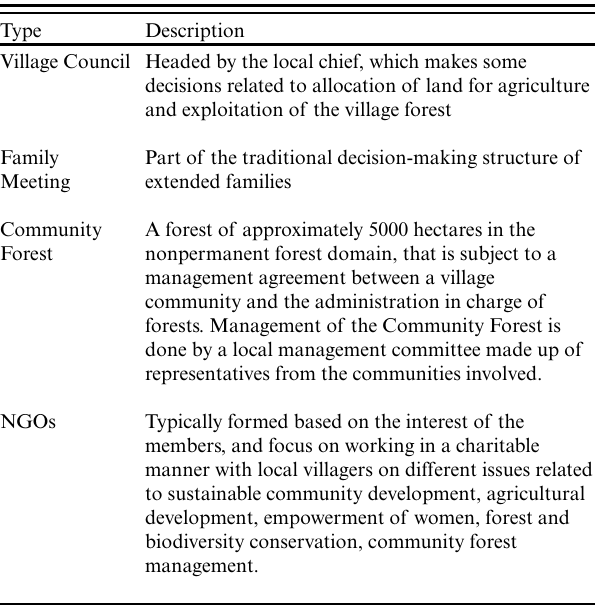
Table 3 . Types of formal local institutions in research area.